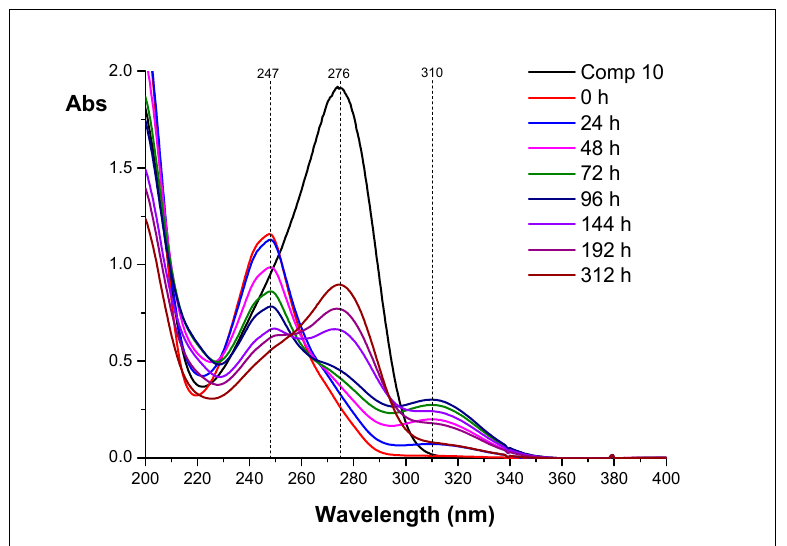
Figure 7. The UV spectra of the reaction mixtures obtained during hydrolysis of 11 (D 2 O, appeared pH 4.1).